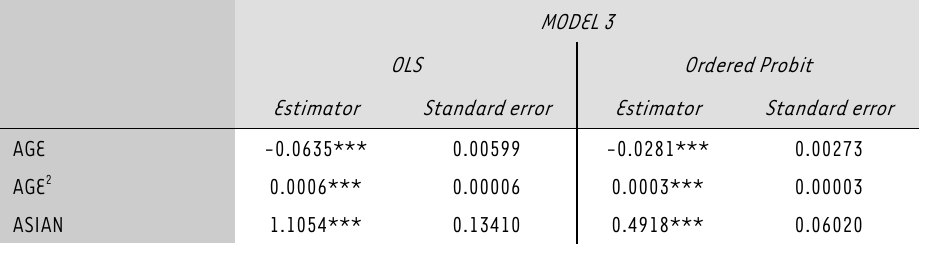
TABLE 4: Concluding estimated well-being